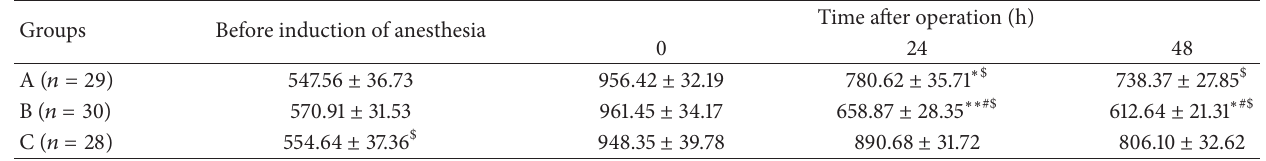
Table 4: Plasma level of TNF- 𝛼 (pg/mL) among the three groups (mean ± SD).